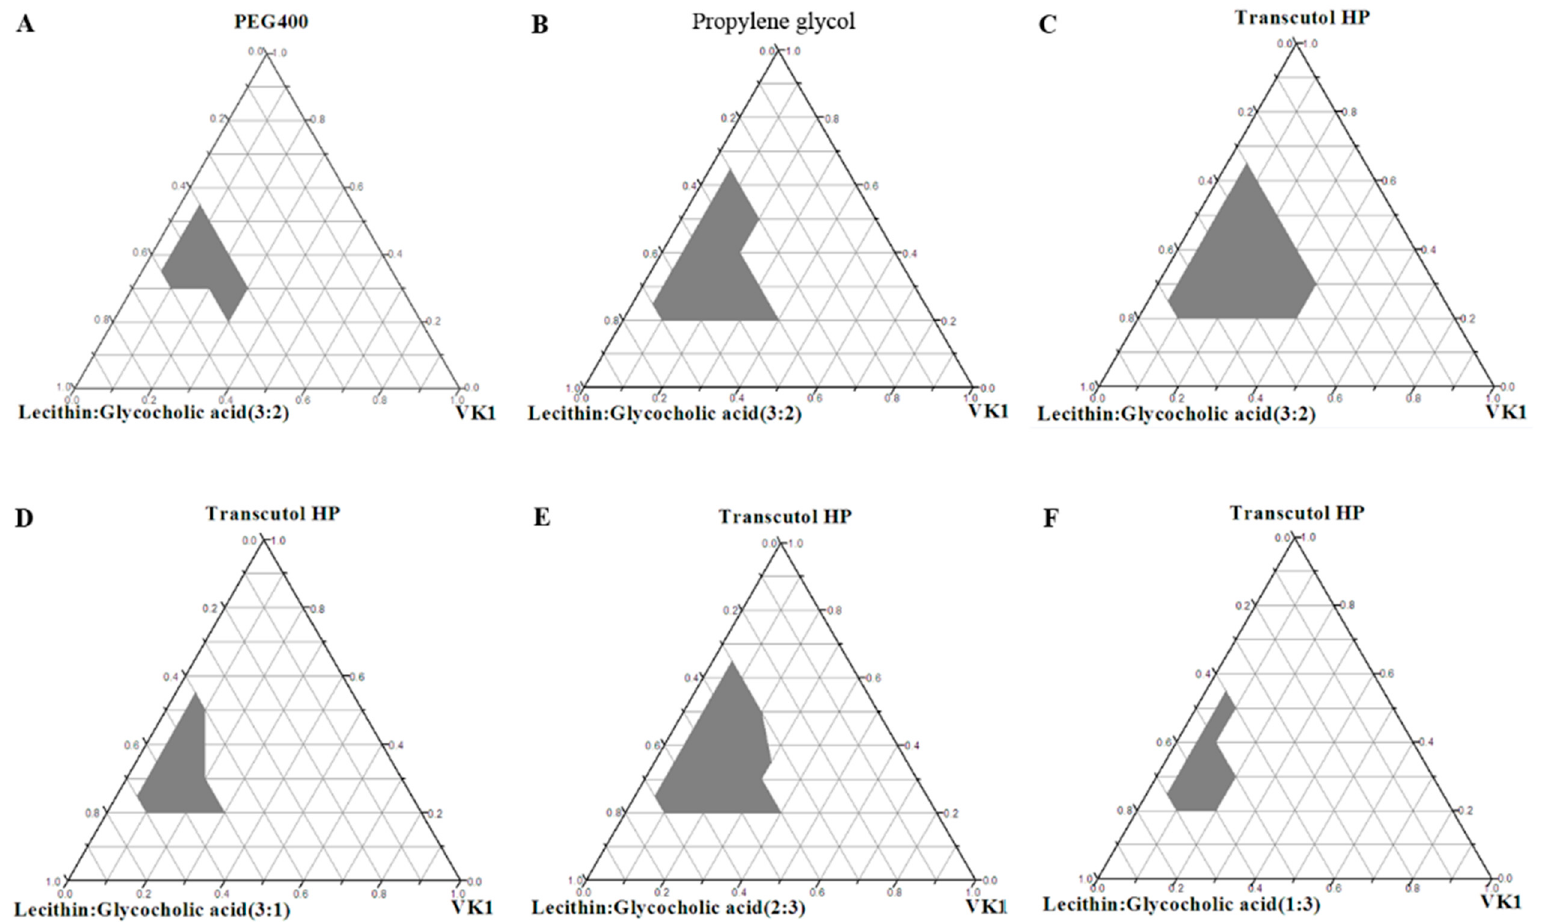
Figure 1. Ternary phase diagrams for oil (vitamin K1), cosurfactant (PEG400, propylene glycol, Transcutol HP), and 3:1, 3:2, 2:3, 1:3 ratios of mixed surfactants (soybean lecithin and glycocholic acid).